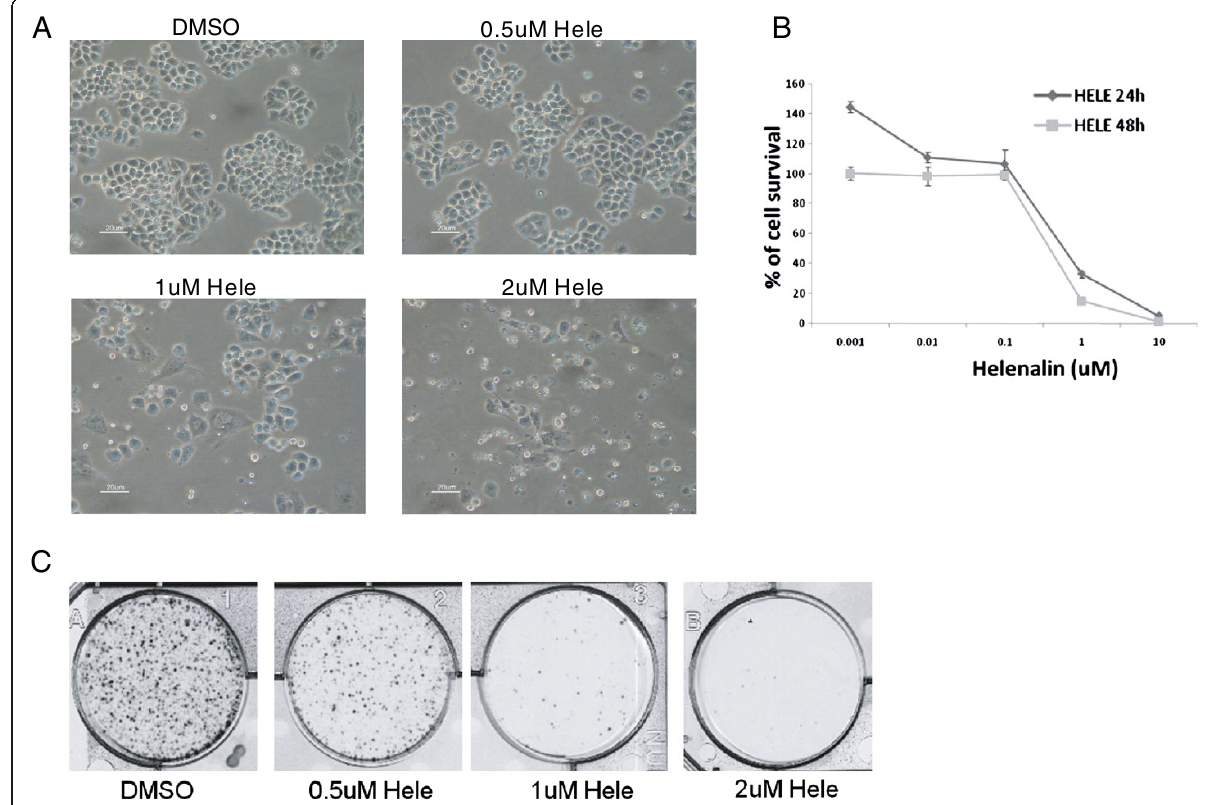
Figure 1 Helenalin induces cytotoxicity in A2780 human ovarian cancer cell line Phase contrast micrographs of A2780 cells treated with increasing concentrations of helenalin of 0.5, 1.0 and 2uM for 24 h. Changes in cell number and morphology were observed when compared to DMSO control. ( B ) Percent of viable cells after treatment with increasing concentrations of helenalin (serial dilution for drug concentration ranging from 10uM to 0.001uM) using the MTT assay. ( C ) Clonogenic survival assay. A2780 cells were treated with increasing concentrations of helenalin and then incubated for 2 weeks. The cells were stained with crystal violet for 16 h. Representative dishes are shown. All results represent data from three independent